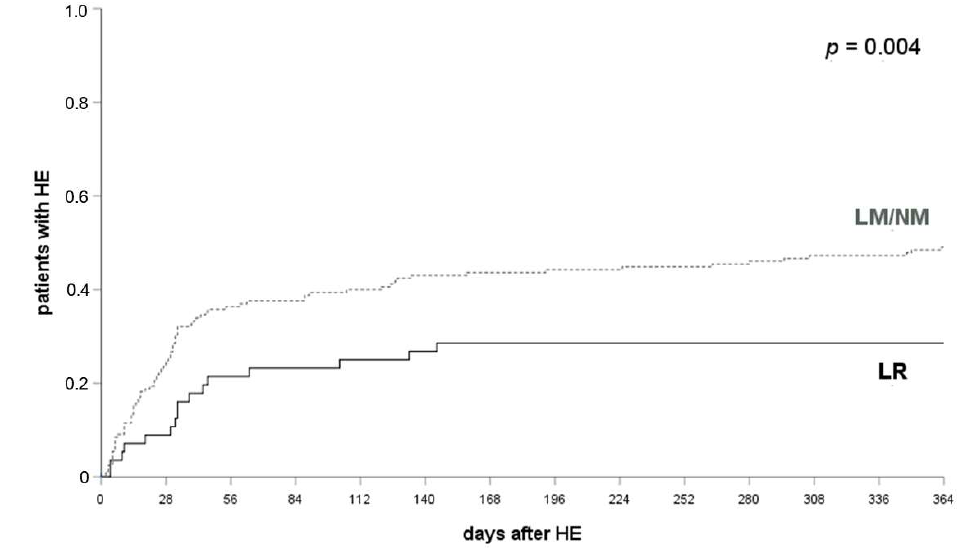
Figure 2. HE occurrence in patients with LR and LR/NM. HE occurred in 36.1% of patients with LM or NM and 15.8% of patients with LR at 1 month ( p = 0.007), 42.6% and 25.0% at 3 months ( p < 0.05) and 52.1% and 28.1% at 12 months after their TIPS implantation ( p = 0.004). A log-rank test was applied. HE, hepatic encephalopathy; LR, lactulose and rifaximin; LM, lactulose monoprophylaxis; NM, no prophylactic